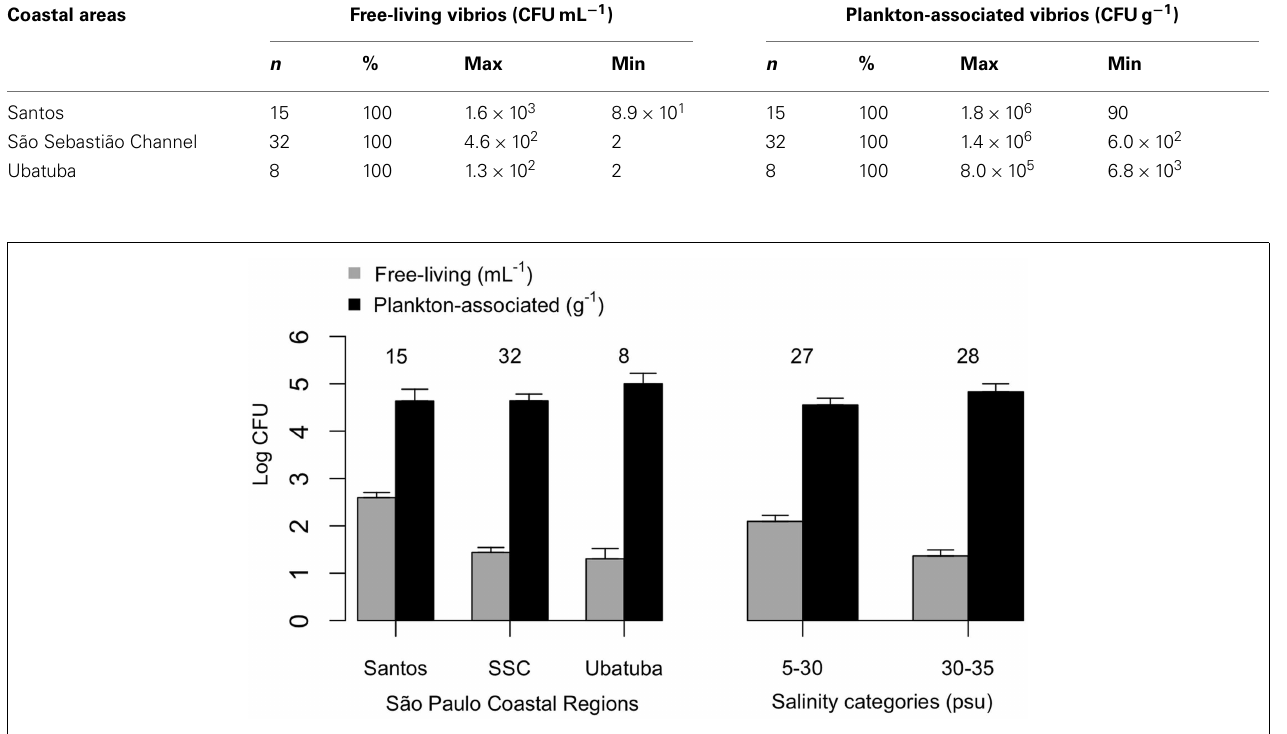
Table 4 | Vibrio frequency and concentration range on coastal areas of São Paulo State, Brazil. Coastal areas